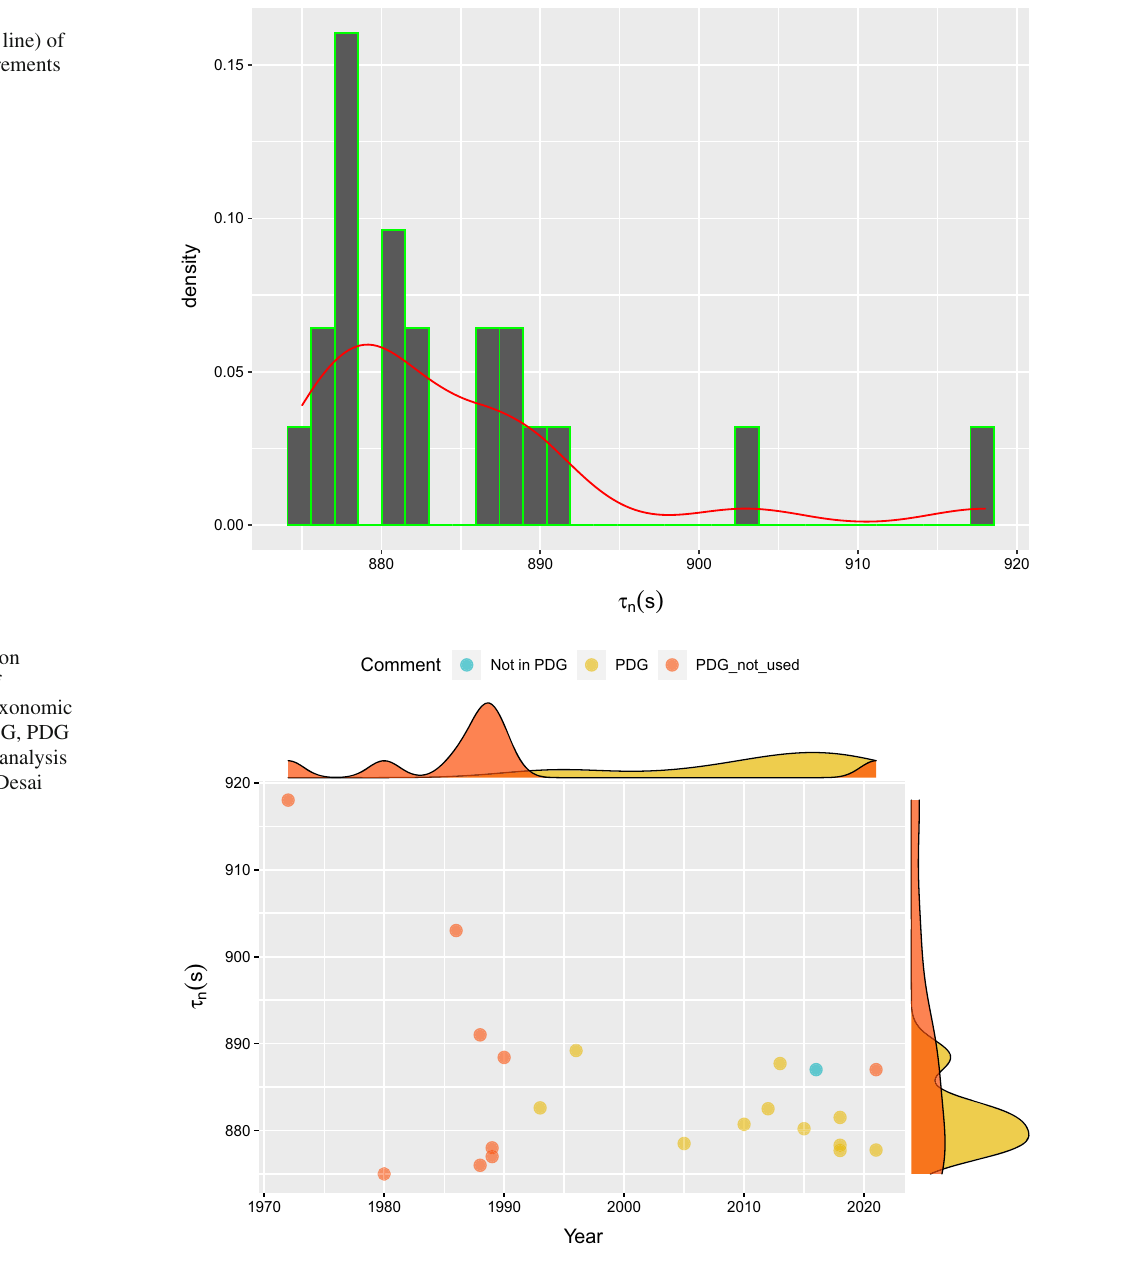
Fig. 2 Published neutron lifetime as a function of publication date. The taxonomic approach of Not_in_PDG, PDG and PDG_not_used for analysis is similar to Rajan and Desai